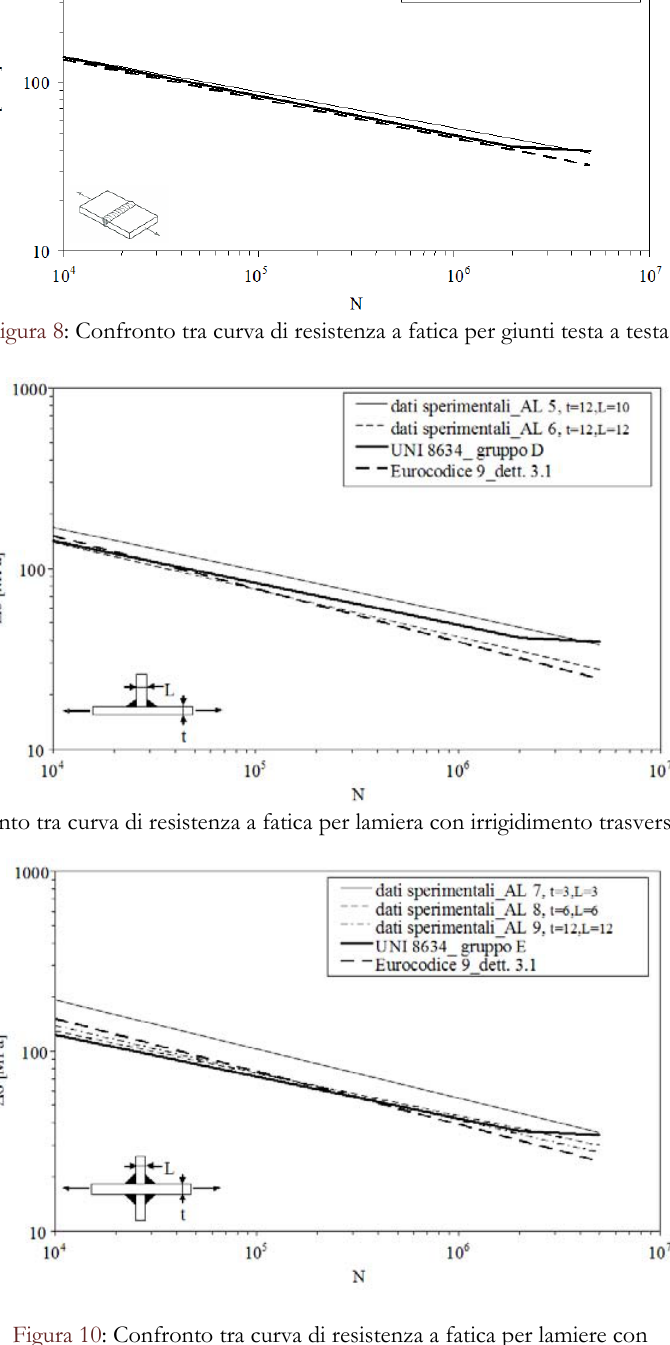
Figura 10: Confronto tra curva di resistenza a fatica per lamiere con irrigidimenti trasversali simmetrici (giunti a croce,cordone non